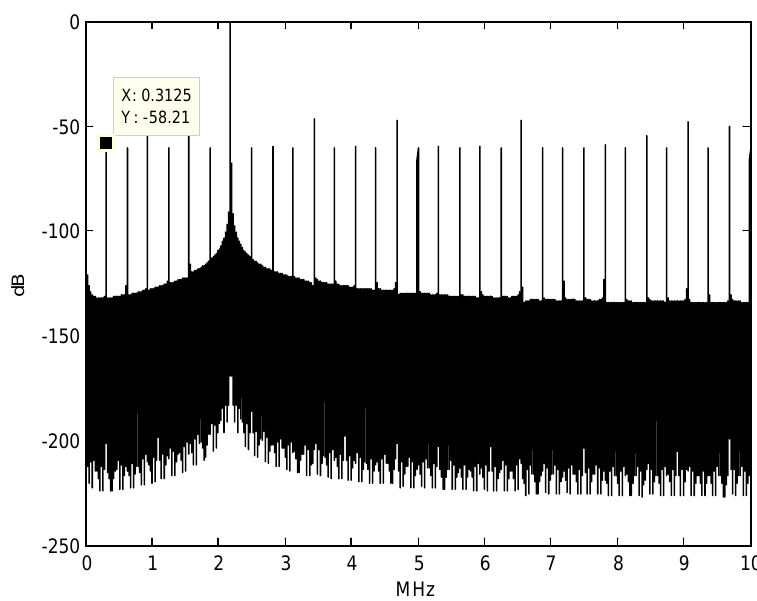
Figure 11. Amplitude quantization error spurious without phase truncation.